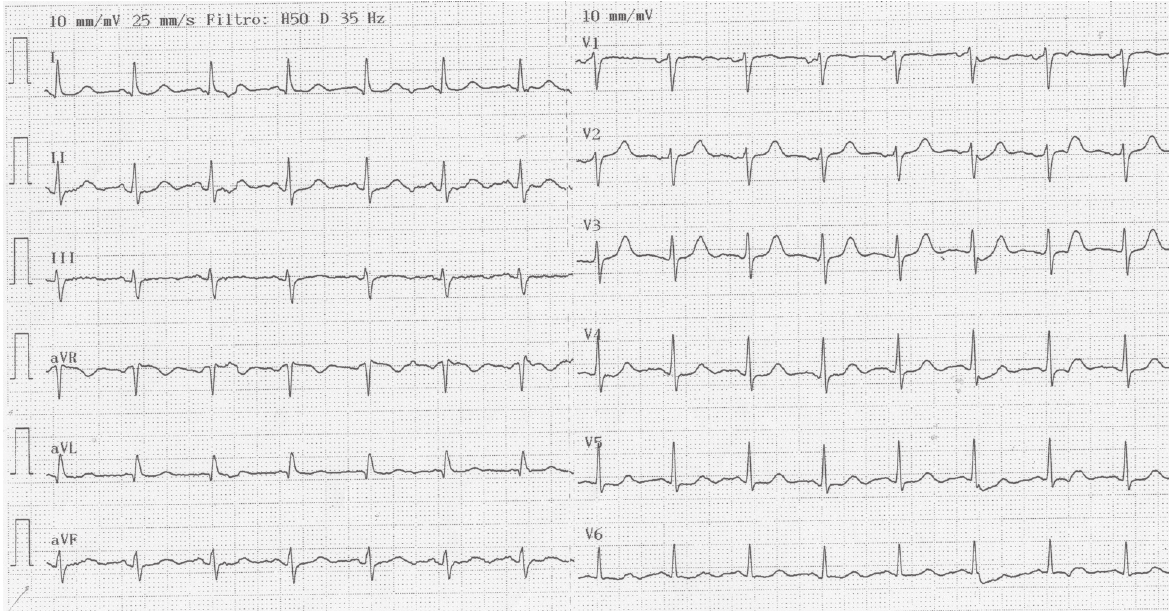
Figure 2. Second electrocardiogram showing the disappearance of ST segment